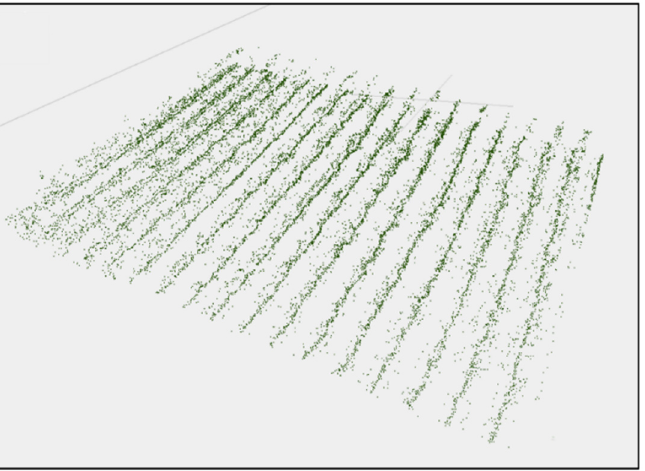
Figure 10. Representation of the tie points from the images detected by the UAV that represent the vineyard rows.